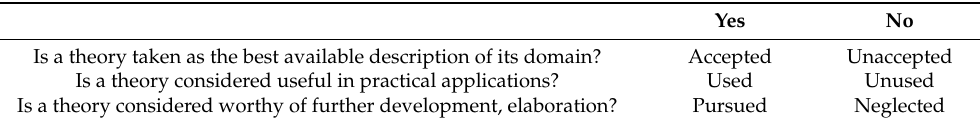
Table 1. The suggested taxonomy of